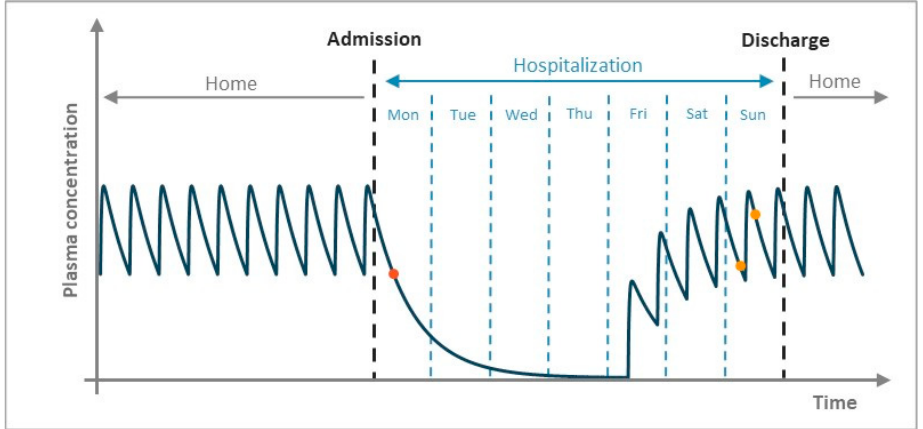
Figure 1. Schematic representation of a concentration/time profile of levetiracetam before, during and after hospitalization. The orange point represents the plasma concentration of levetiracetam